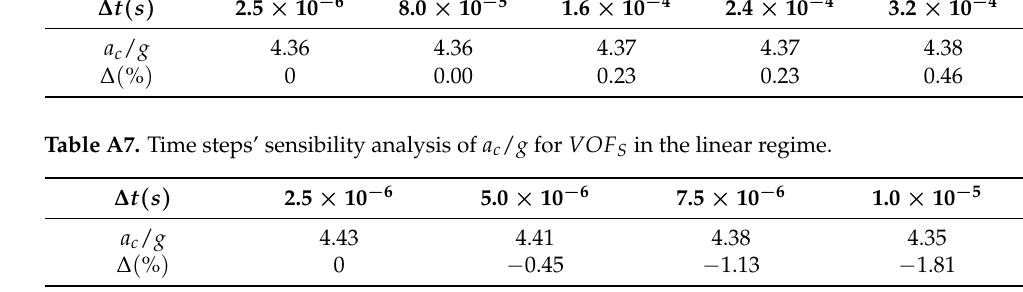
Table A6. Time steps’ sensibility analysis of a c / g for FT S in the linear regime. ∆ t ( s )